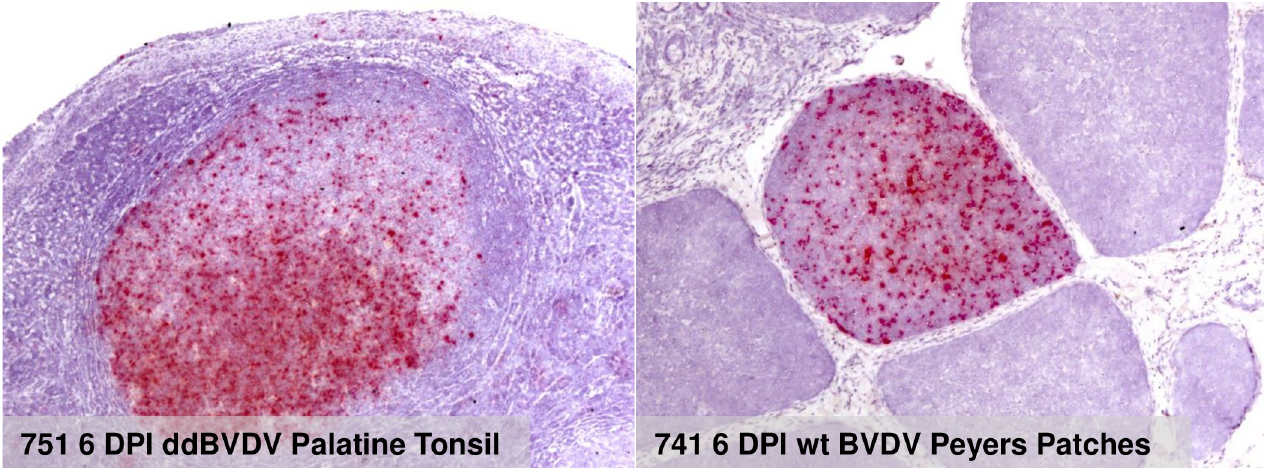
Fig 6. Detection via RNAscope of genomic RNA of ddBVDV in the palatine tonsil of animal 751 and of wt BVDV in Peyers Patches of animal 741, respectively (both from necropsy at 6 DPI). The labeling lists from left to right the animal number, the day of slaughter, the virus used for infection and the tissue from which the sample was taken. Red color represents positive staining.